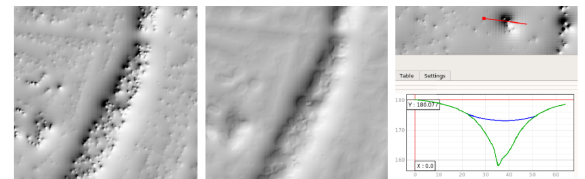
Figure 12. Left: DTM with pits from the DTM extraction step. Center: DTM after the post-processing step. Right: pit profile (Green: DTM from DTM extraction step, Blue: DTM after post-processing step).